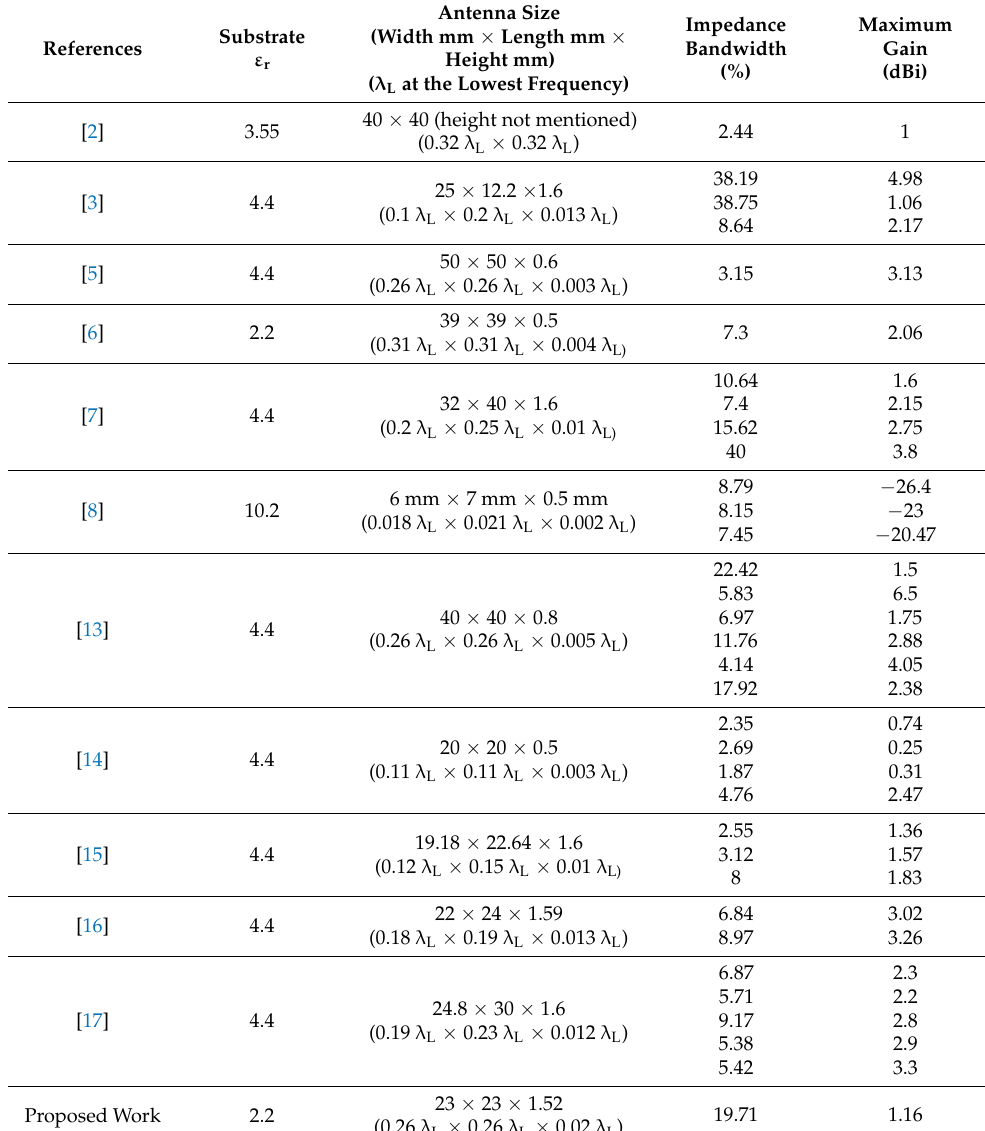
Table 2. Comparison of various compact patch